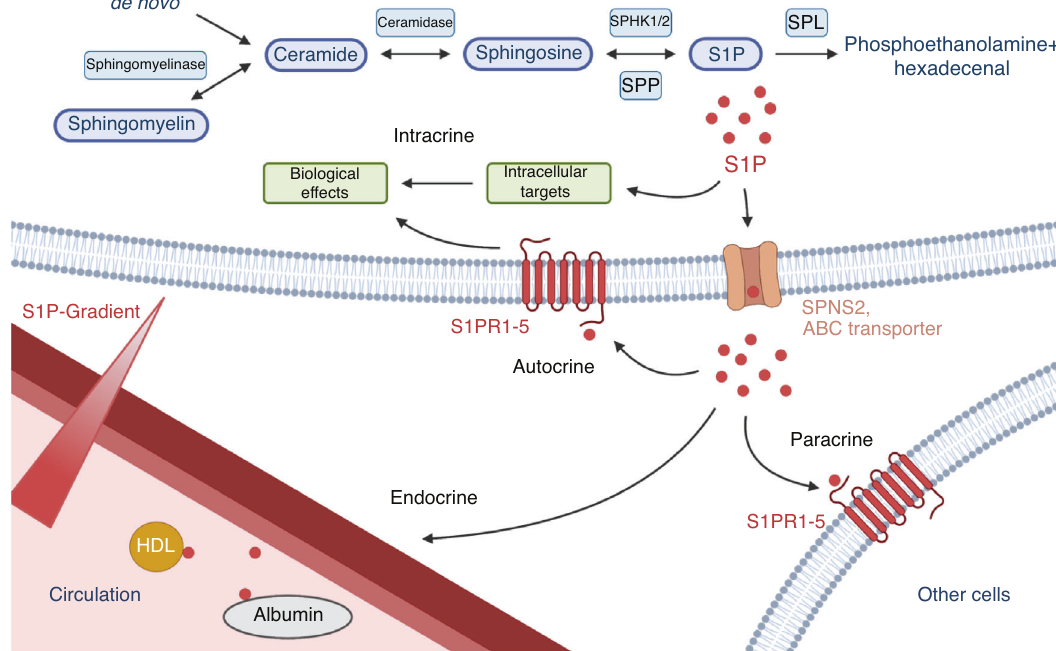
Fig. 1 Biosynthesis and degradation of sphingosine-1-phosphate and its intracrine, autocrine, paracrine and endocrine signaling. Ceramides are synthesized de novo or by the cleavage of sphingomyelin. Then, cytosolic ceramidase catalyzes the hydrolysis to sphingosine. Sphingosine kinases 1 and 2 (SPHK1/2) catalyze the phosphorylation of sphingosine to its bioactive metabolite, namely, sphingosine-1-phosphate (S1P). The intracellular S1P concentration is tightly regulated by its degradation via S1P phosphatases (SPPs) and S1P lyases (SPLs). Bioactive S1P molecules are released by the ATP-independent Spinster 2 (SPNS2) transporter or the ATP-dependent ABC transporter. Subsequently, S1P may act on the host cell in an intracrine or autocrine manner, in a paracrine manner on neighboring cells, or in an endocrine manner via the blood